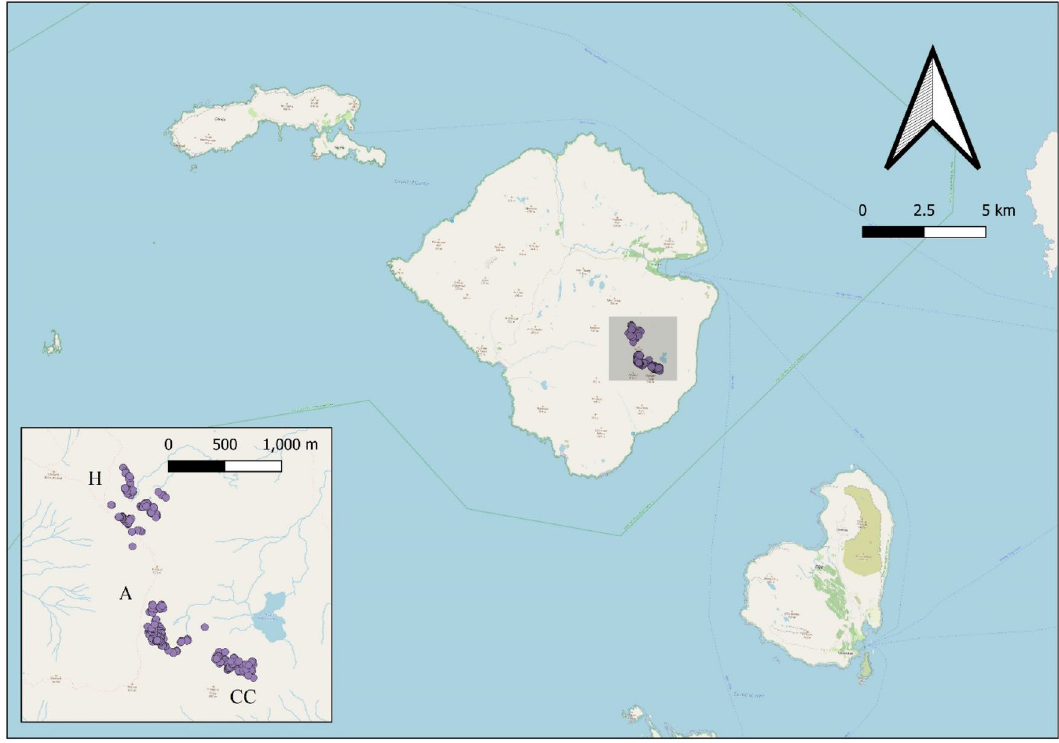
Figure 1. Location of the three study sites Askival (A), Hallival (H) and Clough’s Crag (CC) on the island of Rum, Scotland. Inset shows the location of the individual Manx shearwater burrows which were surveyed by endoscopy in early summer and again in late summer to generate an index of breeding success. Data were plotted using QGIS 3.16.3-Hannover (GNU General Public License). Map data copyright OpenStreetMap contributors, available under the Open Database Licence. Cartography licensed under the Creative Commons Attribution-ShareAlike 2.0 licence (CC BY-SA